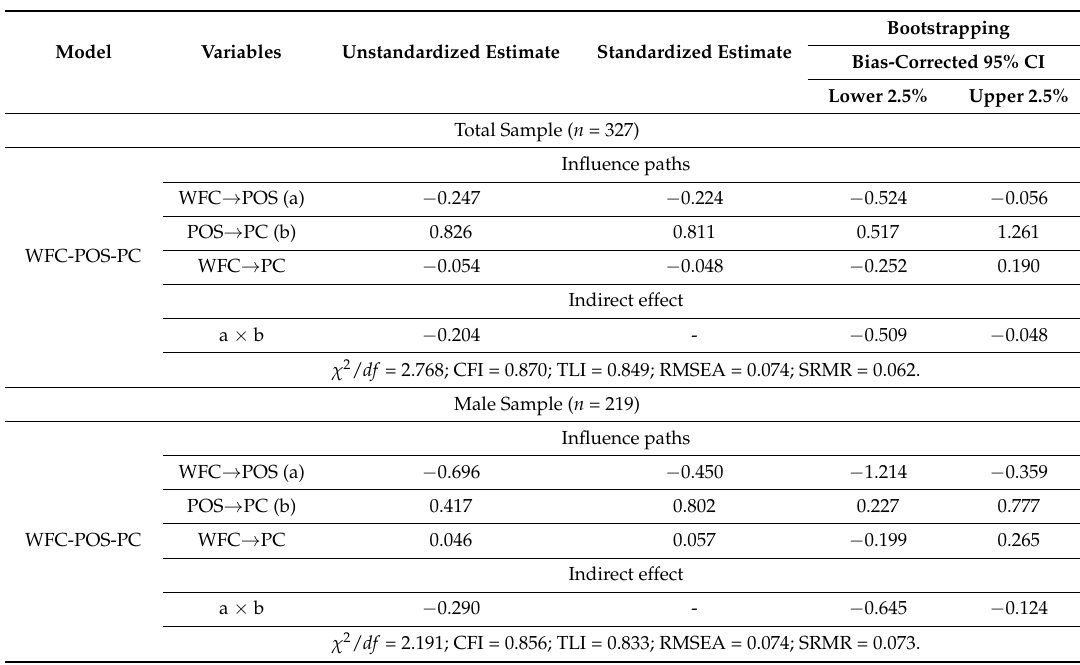
Table 8. The indirect effects testing results of the mediation